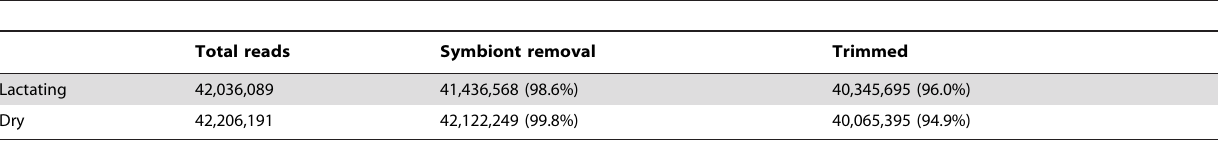
Table 1. Total read number generated by Illumina RNA-seq and following quality control measures including symbiont removal and elimination of low quality